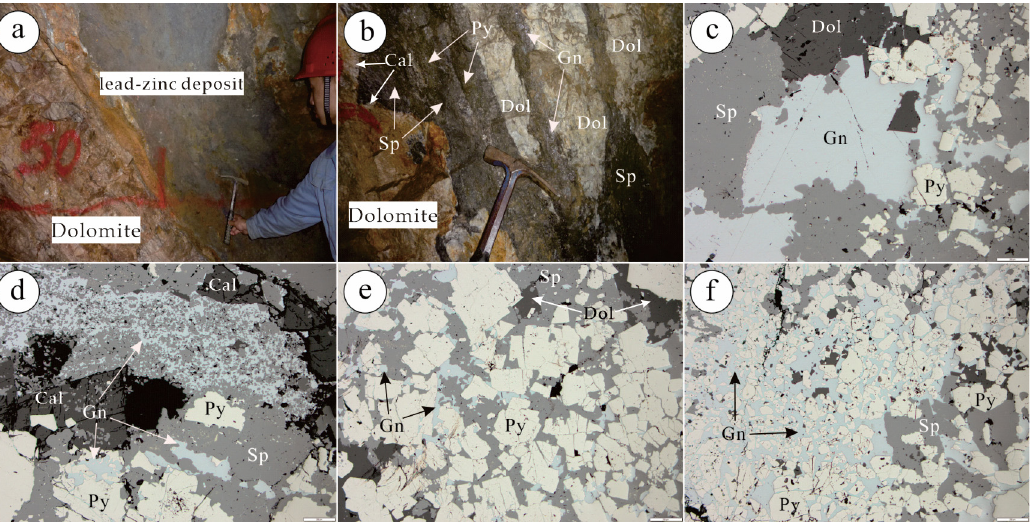
Figure 4. ( a , b ) Contact relationship between the wall rocks and the lead–zinc ore; ( c – f ) characteristics of the minerals under the microscope; Cal: calcite, Dol: dolomite, Sp: sphalerite, Gn: galena, Py: pyrite.